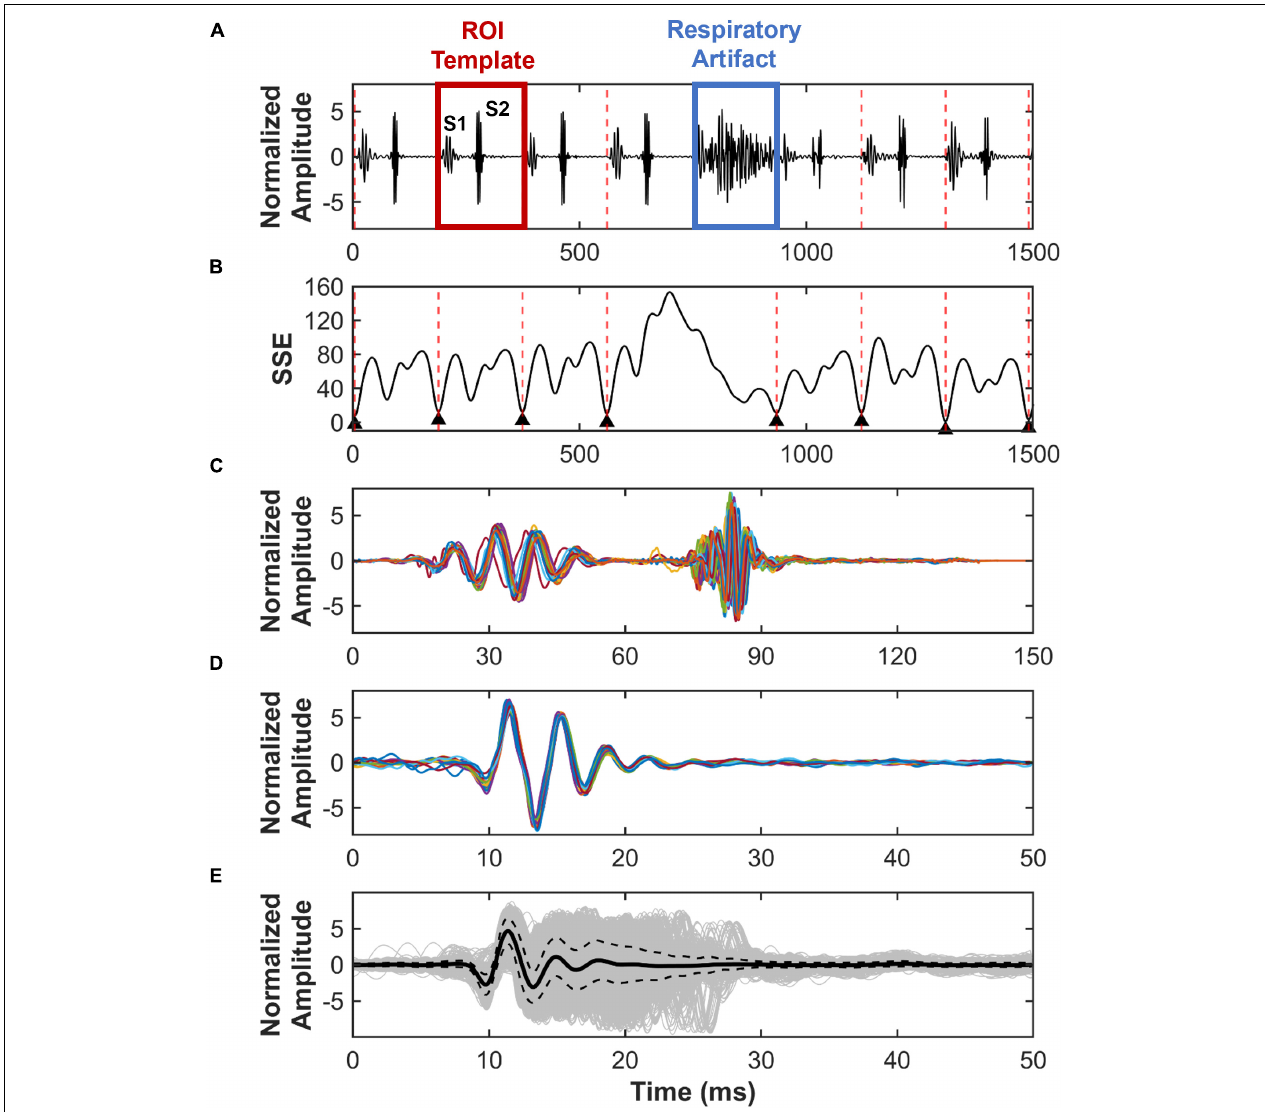
FIGURE 2 | Region of interest – sum-of-squares error (ROI-SSE) segmentation method. Identification and segmentation of S2 sounds from recorded PCG signals. (A) Example of a normalized PCG signal recorded from a mouse, which includes S1 and S2 sounds, respiratory artifacts, and a selected ROI template for cycle segmentation. (B) SSE between ROI template and PCG recording, with the lowest error corresponding to the start of a new cardiac cycle. (C) Example of cardiac cycles segmented using ROI-SSE segmentation method. (D) Ten S2 sounds aligned in time. (E) In gray, superimposed S2 sound waveform of all mice with its average (solid black) and standard deviation (dotted